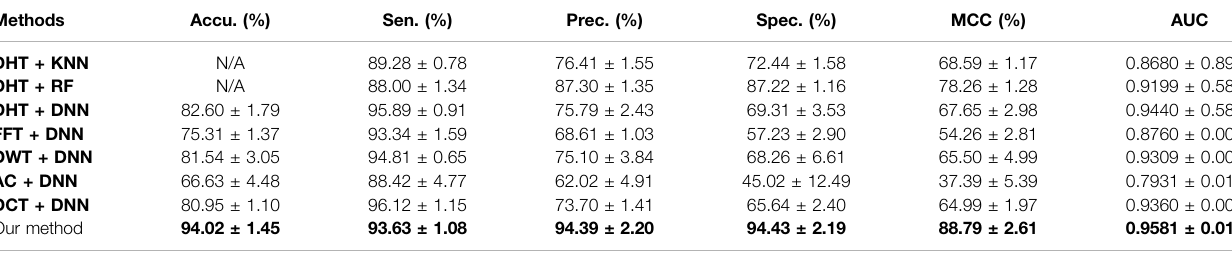
TABLE 6 | The predictive performance comparison of different methods on the Oryza sativa dataset. Methods